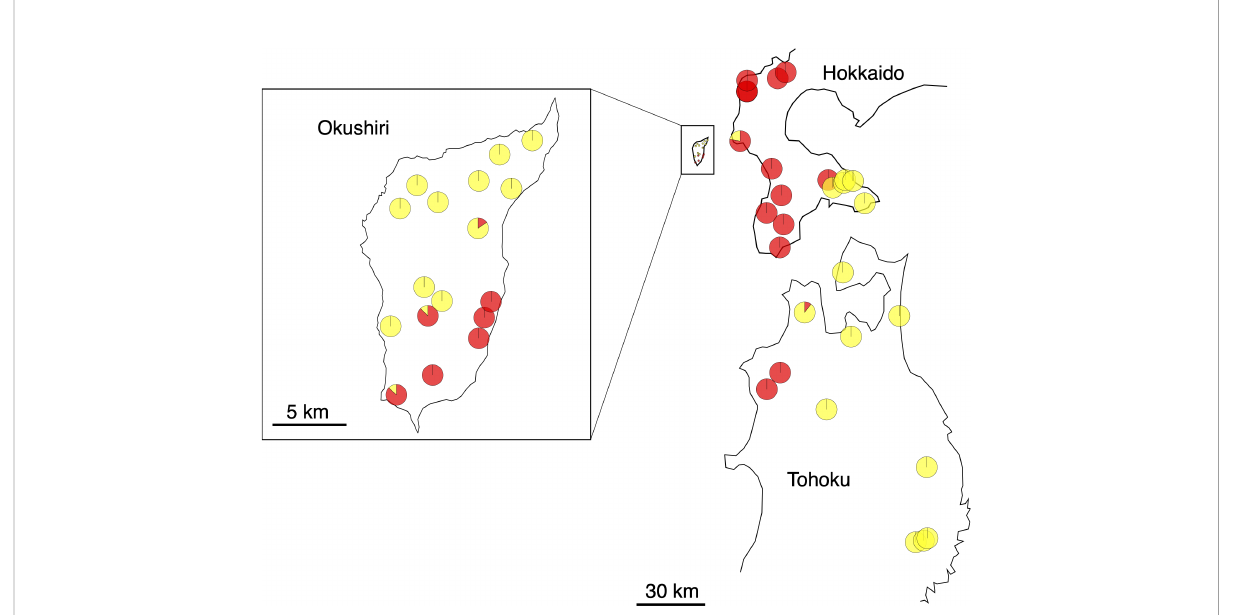
FIGURE 3 Pie diagrams of cpDNA haplotypes. Red and yellow represent haplotype A and B,